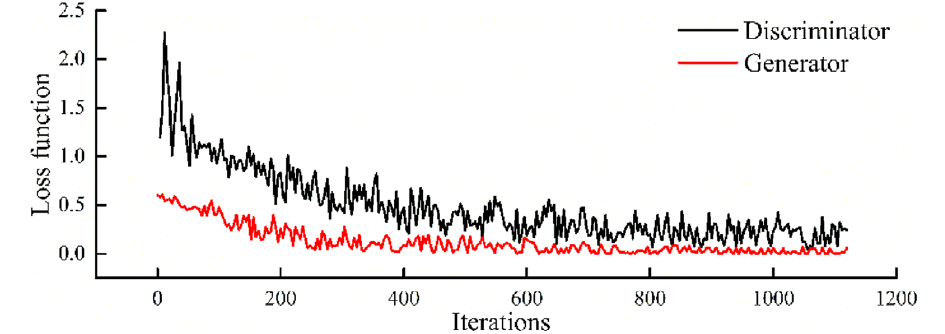
Figure 8. The loss function of GAN.